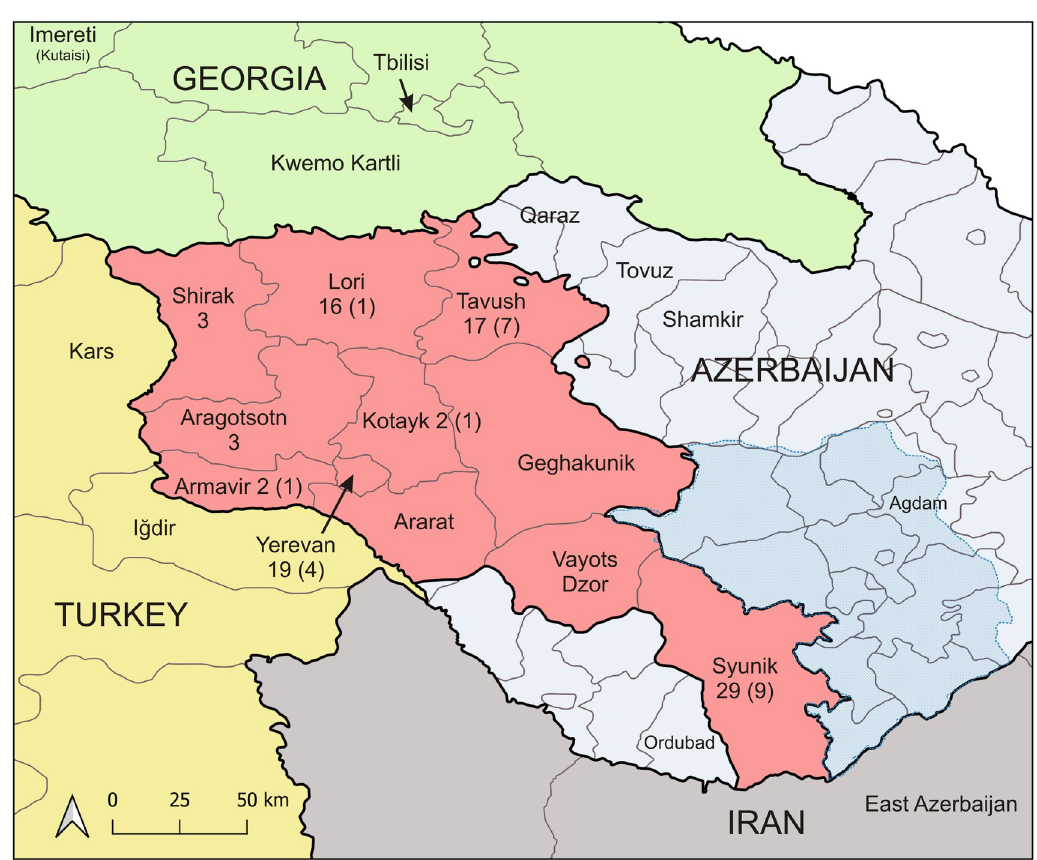
Fig 1. Geographical origin of the studied samples of visceral leishmaniasis. Map showing the distribution of the 91 registered cases of visceral leishmaniasis in 2009–2016 among the districts of Armenia. These cases were used for ecological niche modeling. Out of these 91 cases, 23 were analyzed by Multilocus Microsatellite Typing (in parentheses). Adjacent foci of visceral leishmaniasis in the neighboring countries are indicated. The map was generated by the use of shapefiles available from